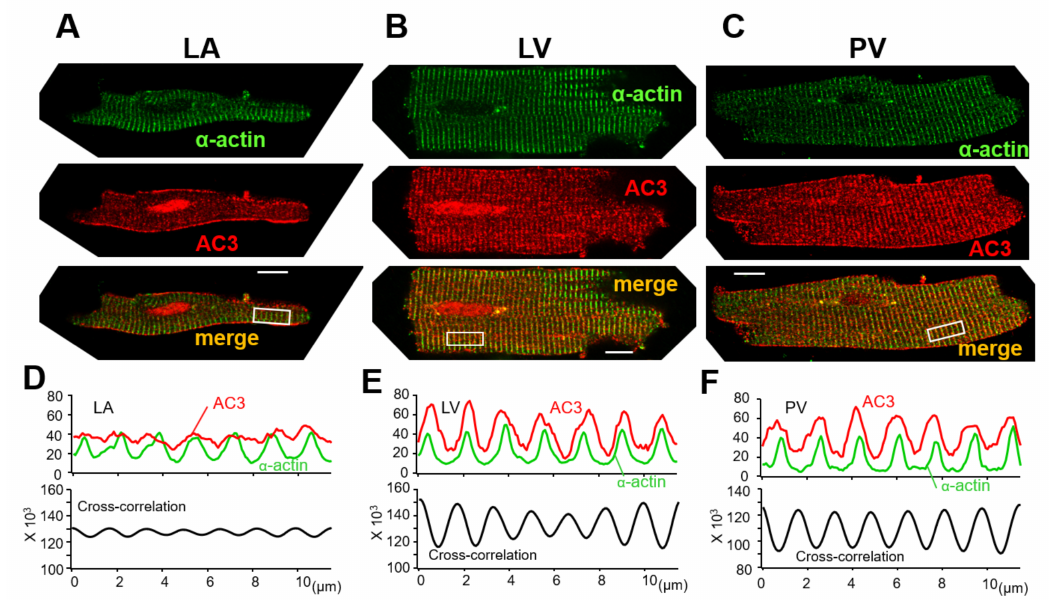
Figure 5. Immunocytochemistry for adenylyl cyclase AC3 in the myocytes of ( A ) isolated left atrium (LA), ( B ) left ventricle (LV), and ( C ) pulmonary vein (PV). α -actinin (green, all top panels) localized to the z-line of cardiomyocytes, indicating the position of the t-tubules. AC3 staining (red, all middle panels) revealed transverse striations in LV and PV myocytes, unlike in LA myocytes. AC3 is strongly expressed along the cell contour in LA myocytes. The bottom panels display the overlay of AC3 on α -actinin (yellow-orange). The white bars in the bottom panel indicate 10 µ m. ( D , E ) and ( F ) display the profiles of α -actin and AC3 staining intensities in ( A – C ), and the cross-correlation between both intensity profiles, respectively. The area to be intensity-profiled is chosen from the rectangular box in the bottom panel of ( A – C ), all of the same size. The cross-correlation waveforms indicate that the intensities of actin and AC3 are synchronized, suggesting that they are localized near each other [11,32]. It should be noted that the nuclei of LA and LV are stained with AC3. Neither the laser intensity of the microscope nor the gain during imaging is increased in these imaging compared to PV imaging. Considering that the transverse microstructures can be captured, it is more likely that the nuclei were stained by anti-AC3 antibody rather than